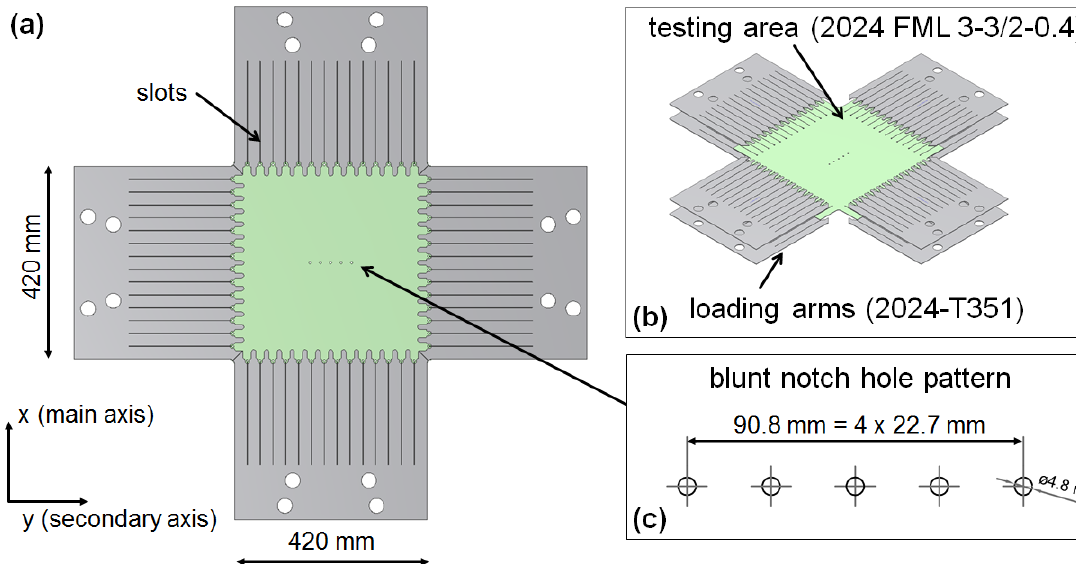
Figure 2. Biaxial specimen design and pattern of blunt notches. ( a ) Biaxial specimen design, ( b ) loading arms and testing area, ( c ) pattern of blunt notches.